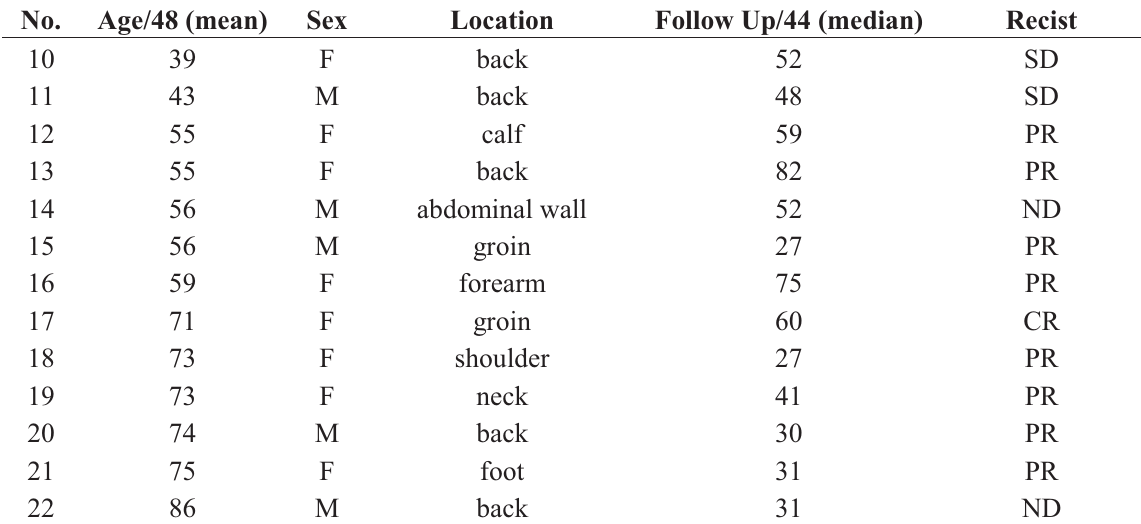
Figure 2. Twenty years old female with desmoid (arrows) in abdominal rectus muscle. ( A ) T2-weighed sagittal image of MRI before meloxicam treatment. ( B ) MRI of